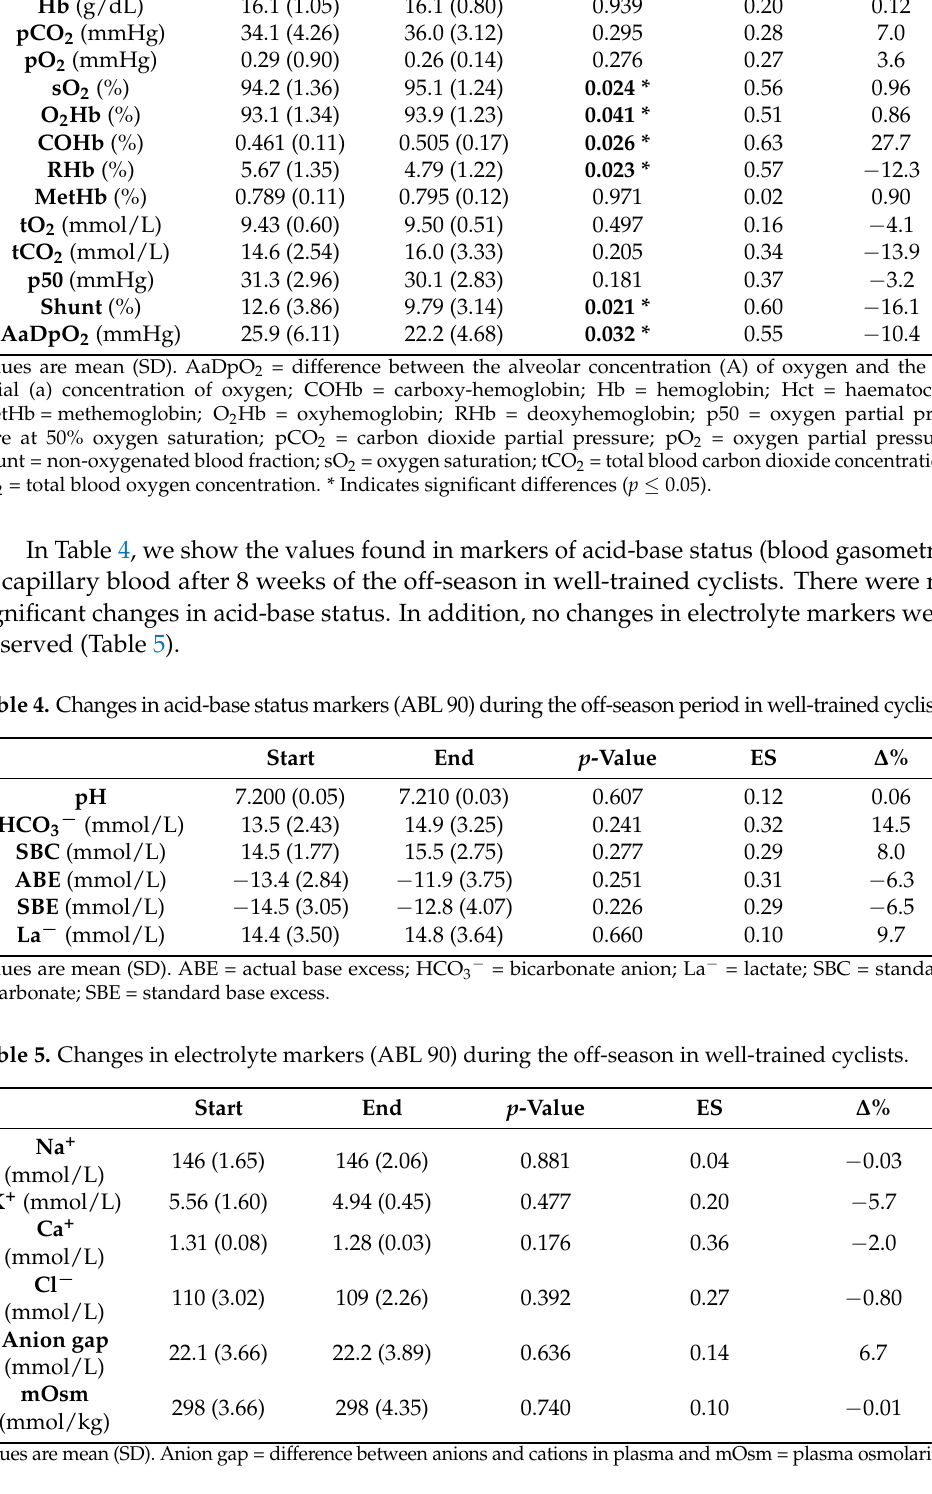
Table 3. Changes in oxygen metabolism markers (ABL 90) during the off-season in well-trained cyclists. Start End p -Value ES ∆ % Hct (%)